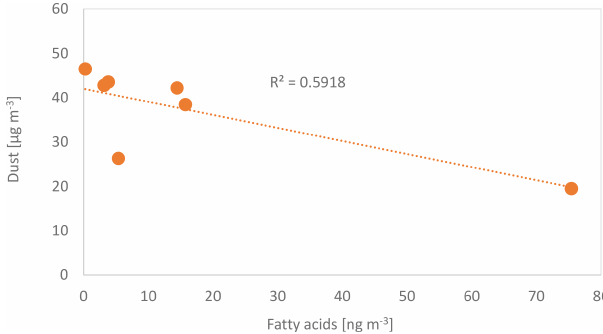
Figure 13. Straight-chain unsaturated fatty acid ( (cid:54) ; C12 to C33) concentrations on the PM 10 aerosol particles versus atmospheric dust